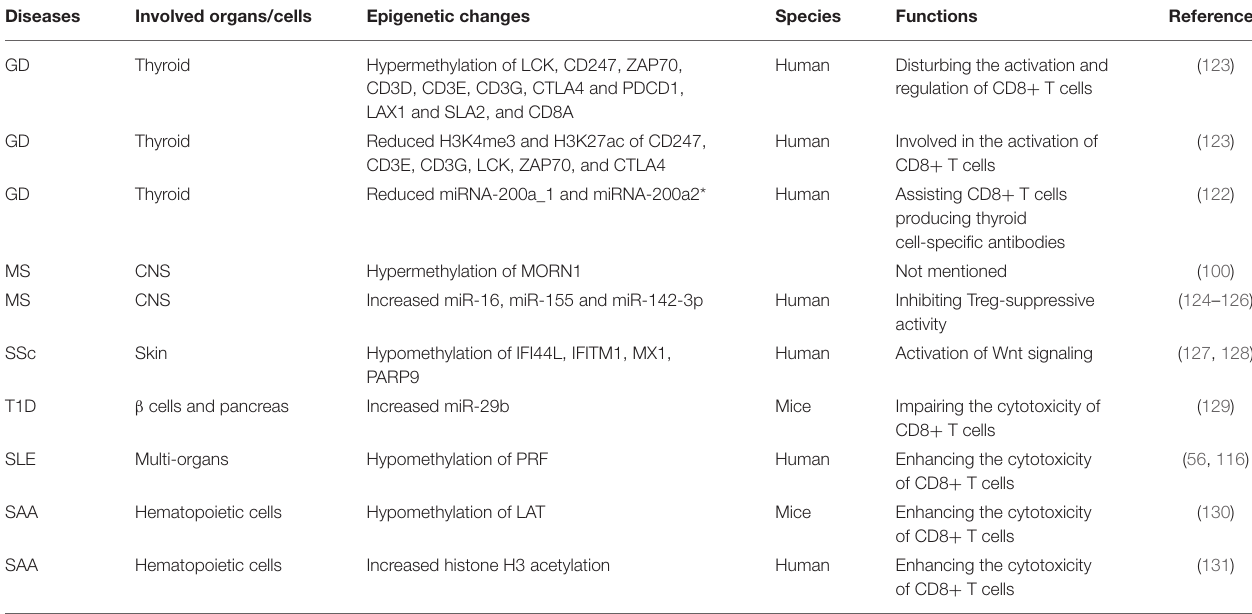
TABLE 2 | Epigenetic changes of CD8 + T cells in different autoimmune